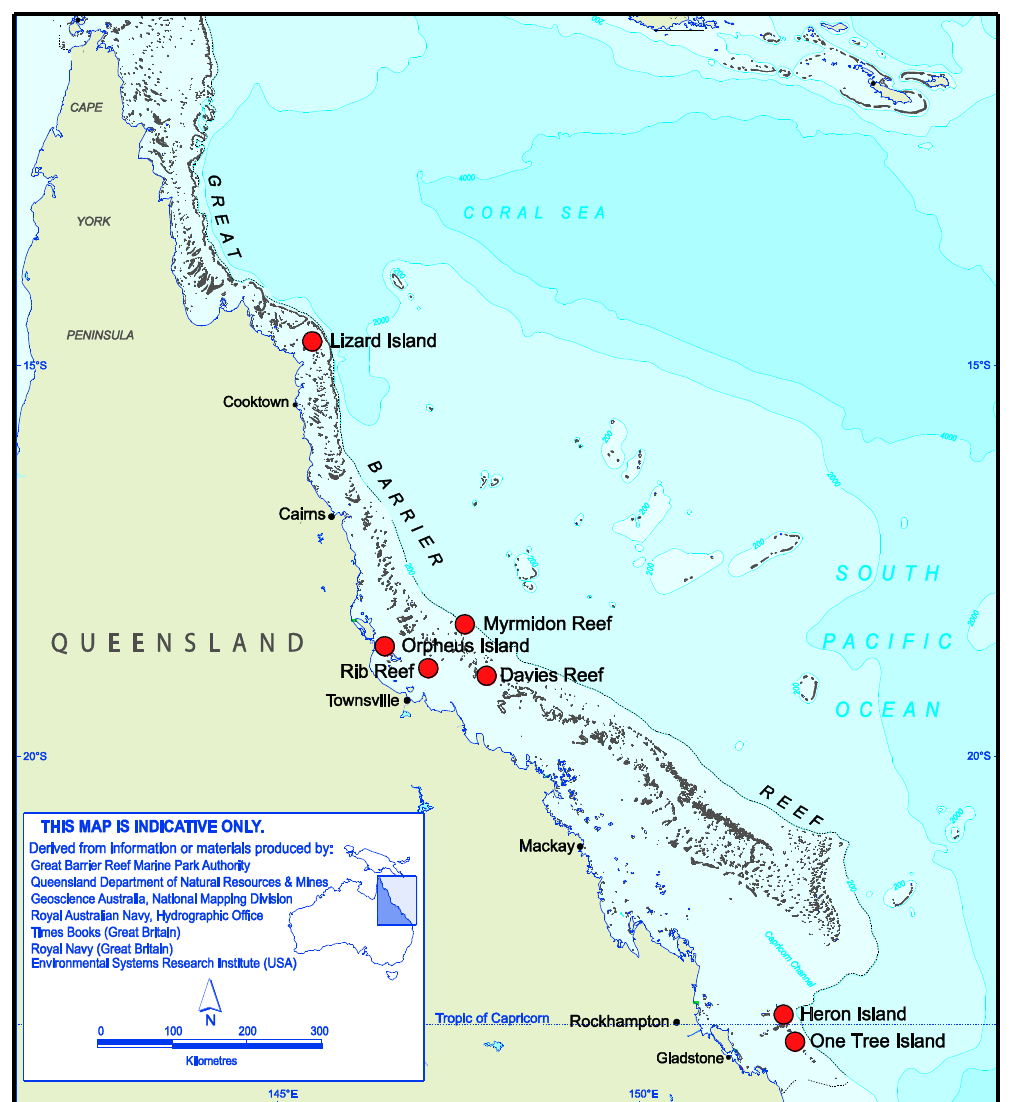
Figure 1. Map of the Sensor Network sites (red dots) along the Great Barrier Reef,